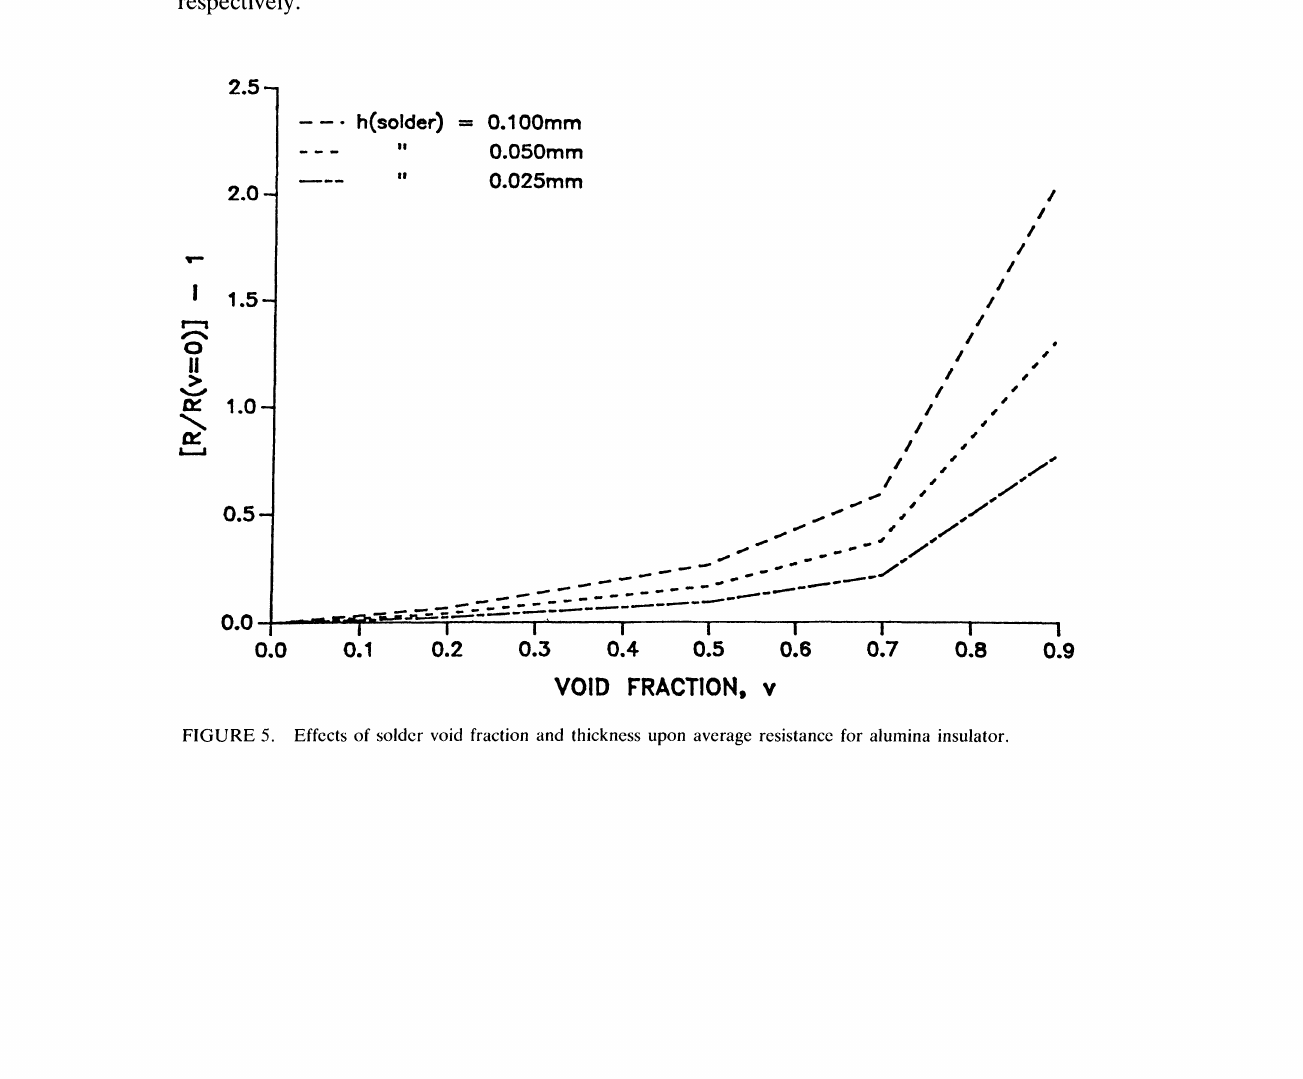
FIGURE 5. Effccts of soldcr void fraction and thickness upon average resistancc for alumina